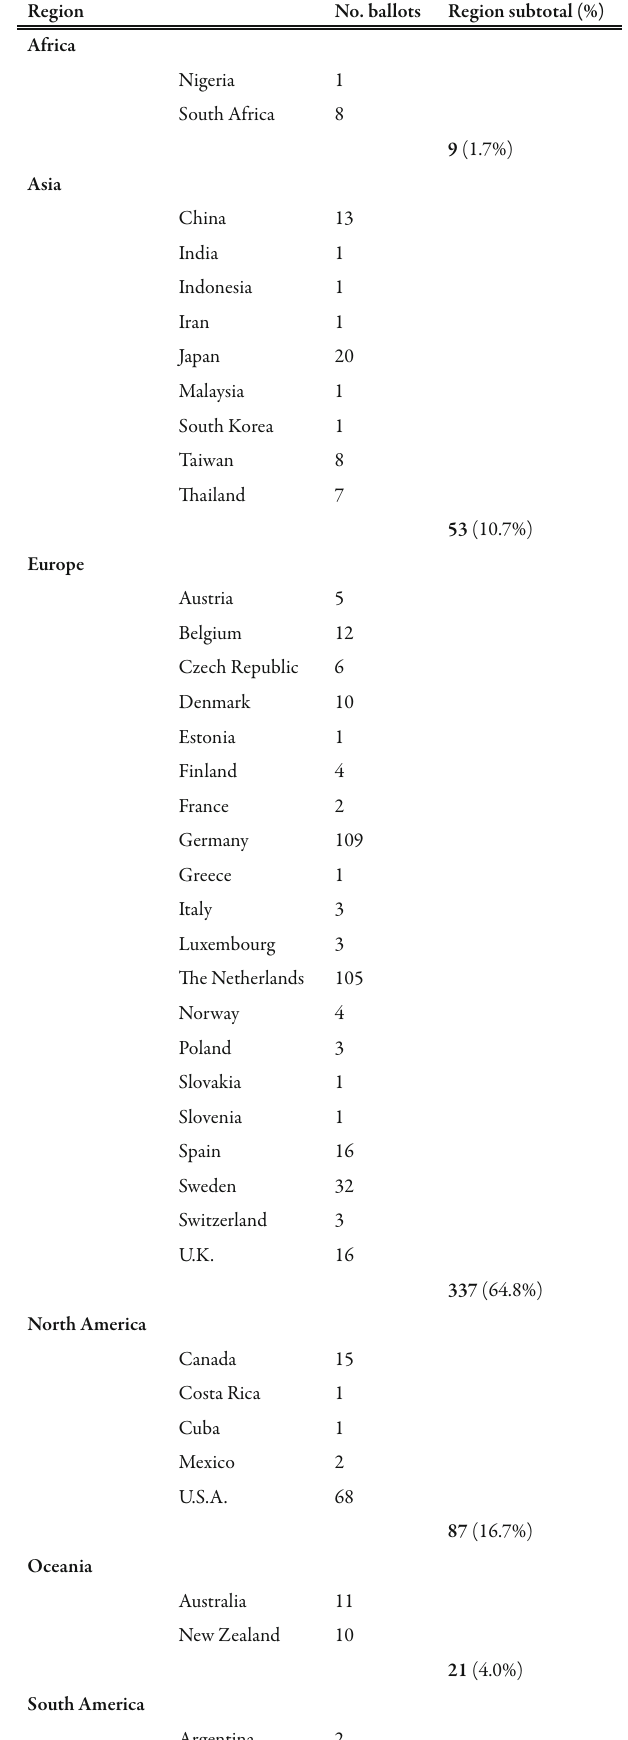
Table 3. Breakdown of valid ballots by country and region.